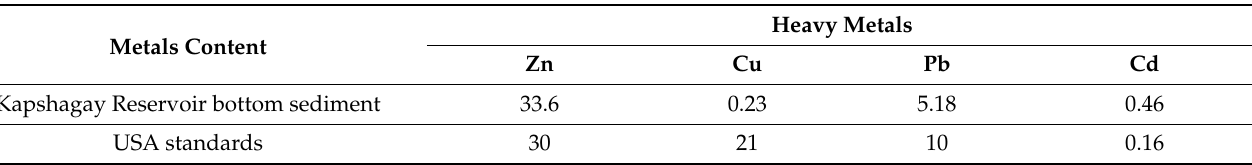
Table 2. Comparison of measured heavy metal concentrations in reservoir bottom sediment with standards from USA [61]